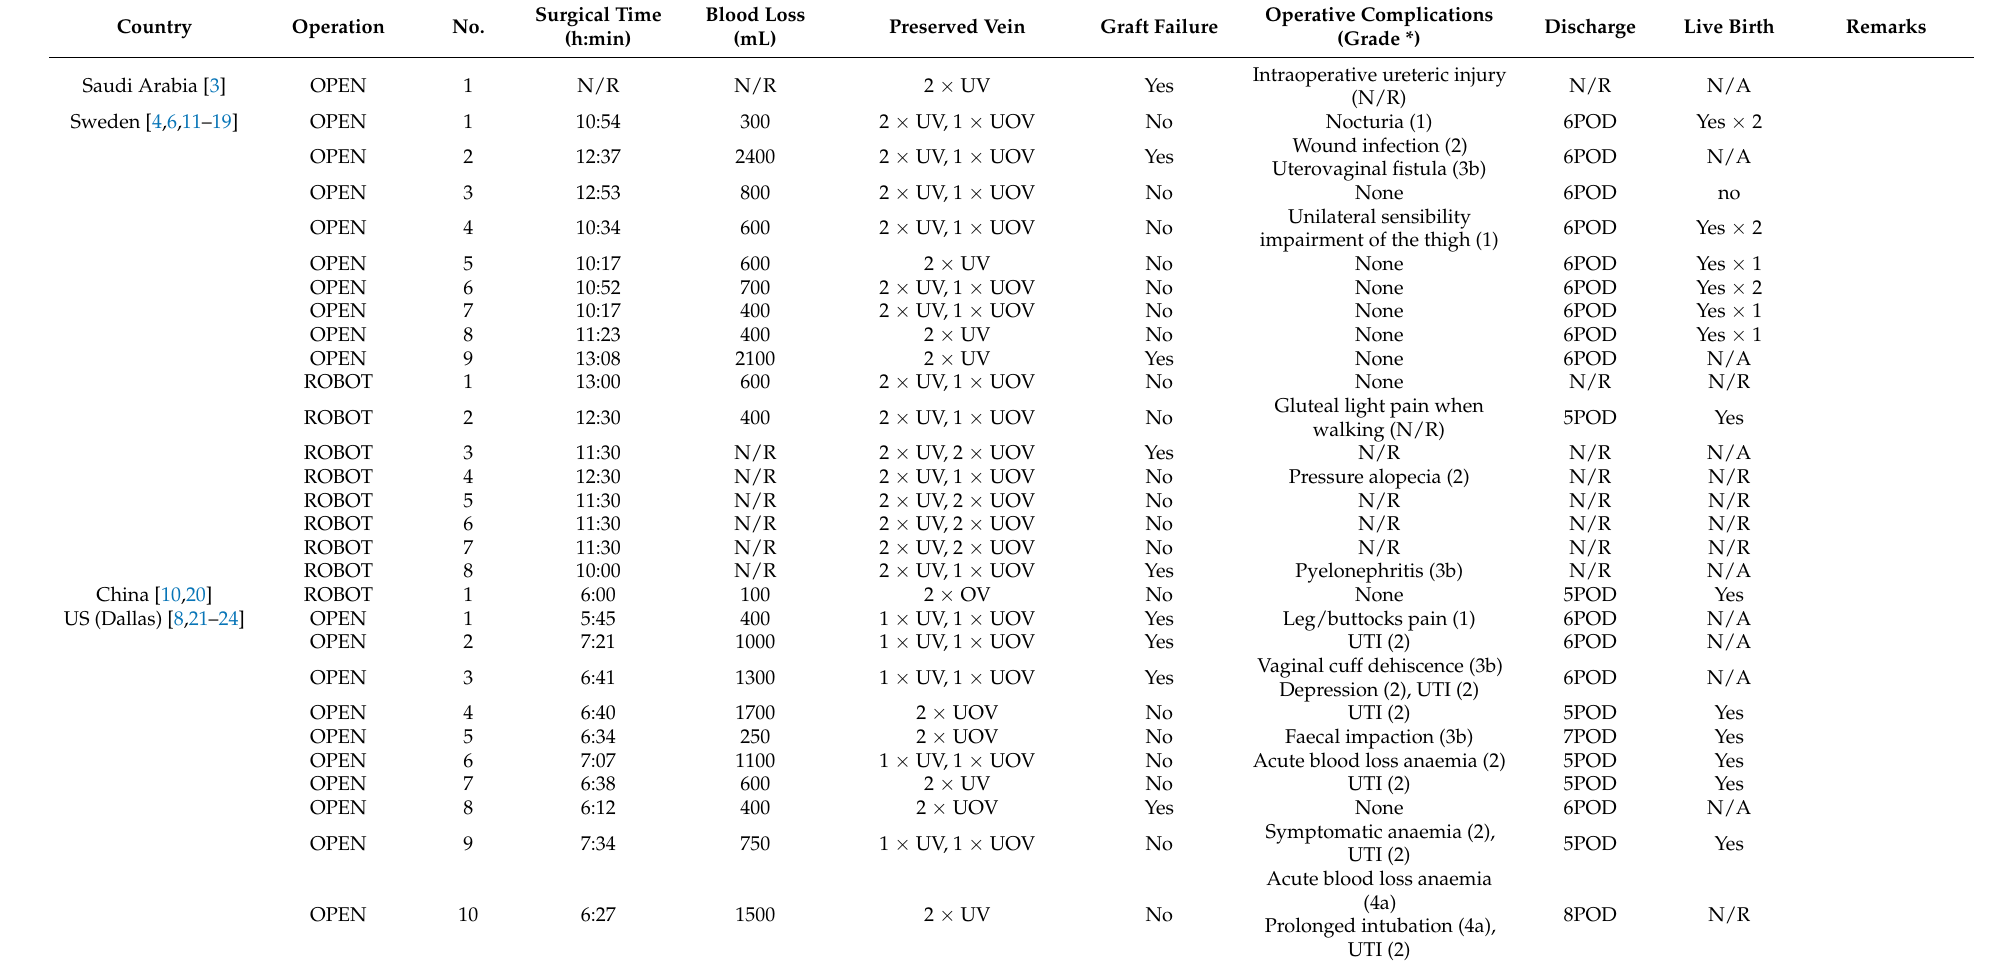
Table 1. Reported operative and clinical data of living-donor surgery for uterus